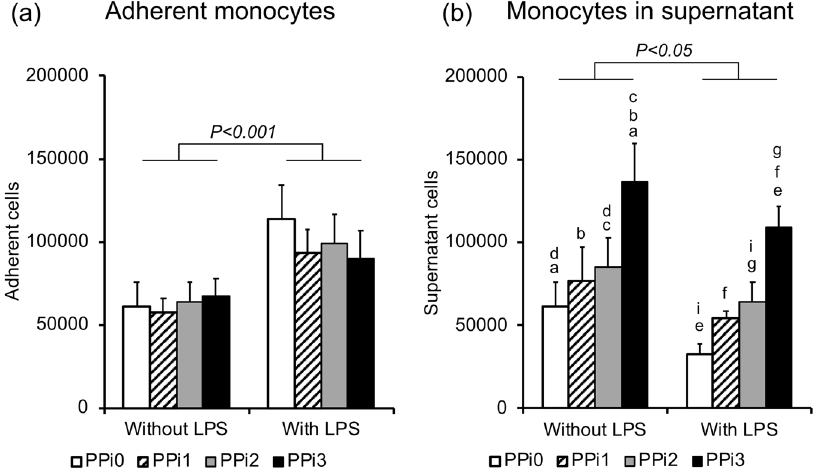
Fig. 2 Cell count of monocytes. Cell count of adherent monocytes ( a ) and monocytes in the culture media/supernatant ( b ). Number of monocytes after 48 h of culture in polystyrene plates in the presence or absence of lipopolysaccharide (LPS) and exposed to different con- centrations of pyrophosphate (PPi): 0 μ M (PPi0), 50 μ M (PPi1), 100 μ M (PPi2) and 250 μ M (PPi3). The bar graphs show the means